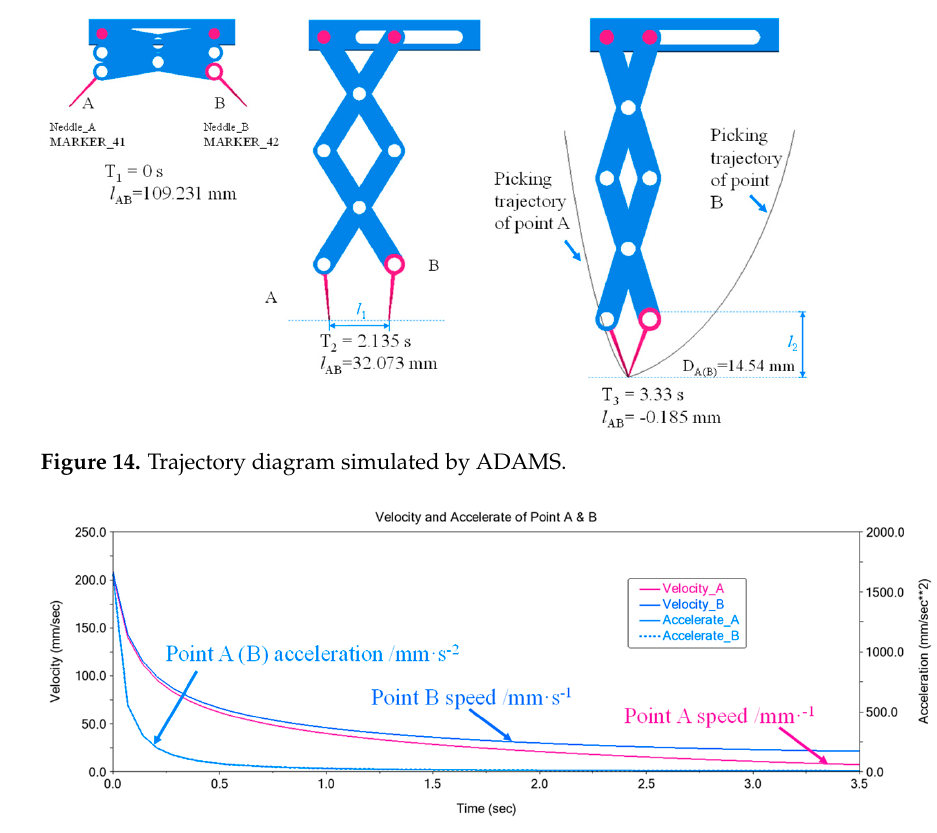
Figure 15. Velocity and acceleration at points A and B.